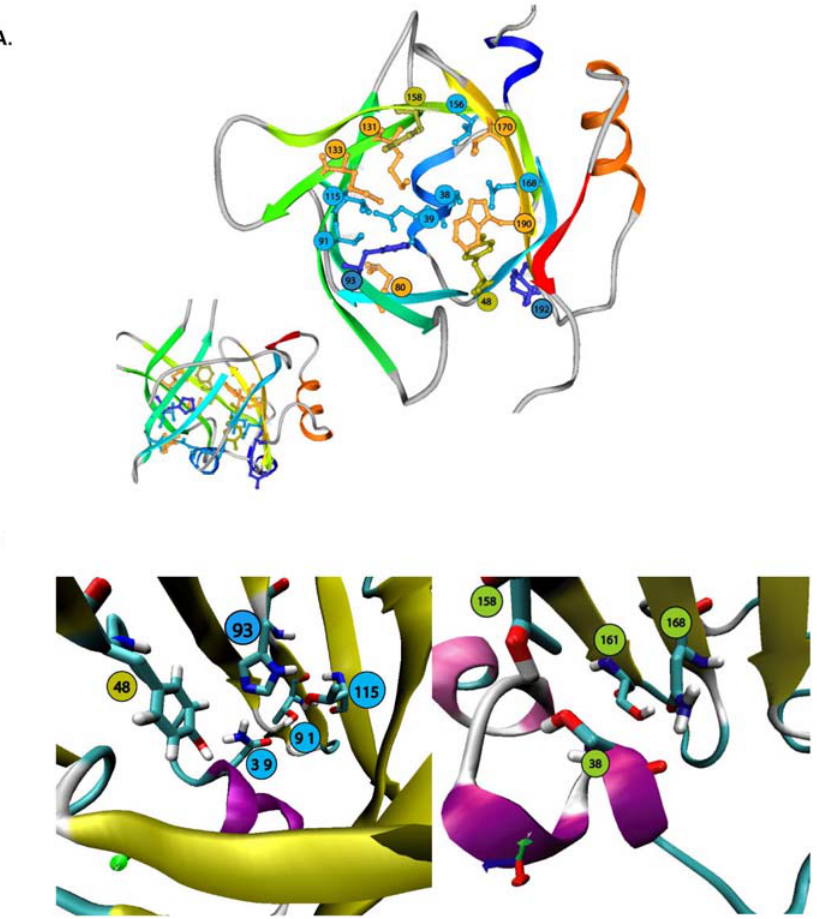
Figure 3. Model of Ir-LBP with the residues corresponding to the conserved internal lipocalin cluster. A. The protein is viewed from the top (right) and front (left). The protein is represented by a ribbon, colored by secondary structure succession. Positive residues are in blue, hydrophobic residues in orange, hydrophilic residues in light blue, and Tyr in green. The corresponding V loop is not represented for the sake of clarity. B. Details of the bottom of the cavity of Ir-LBP . The protein is represented by a ribbon. The strands are in yellow and H1 is in purple.